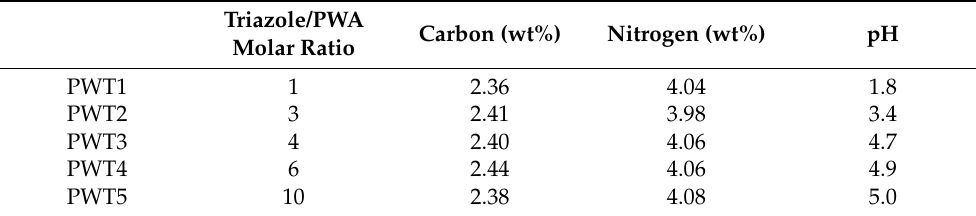
Table 1. Element analysis (EA) results of the synthesized catalysts and pH changes of the synthesis solution when increasing the number of triazole moieties. Triazole/PWA Molar